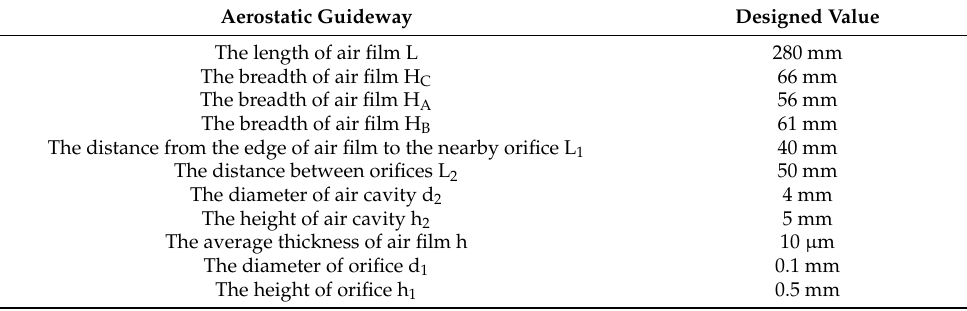
Table 1. Structural parameters of the